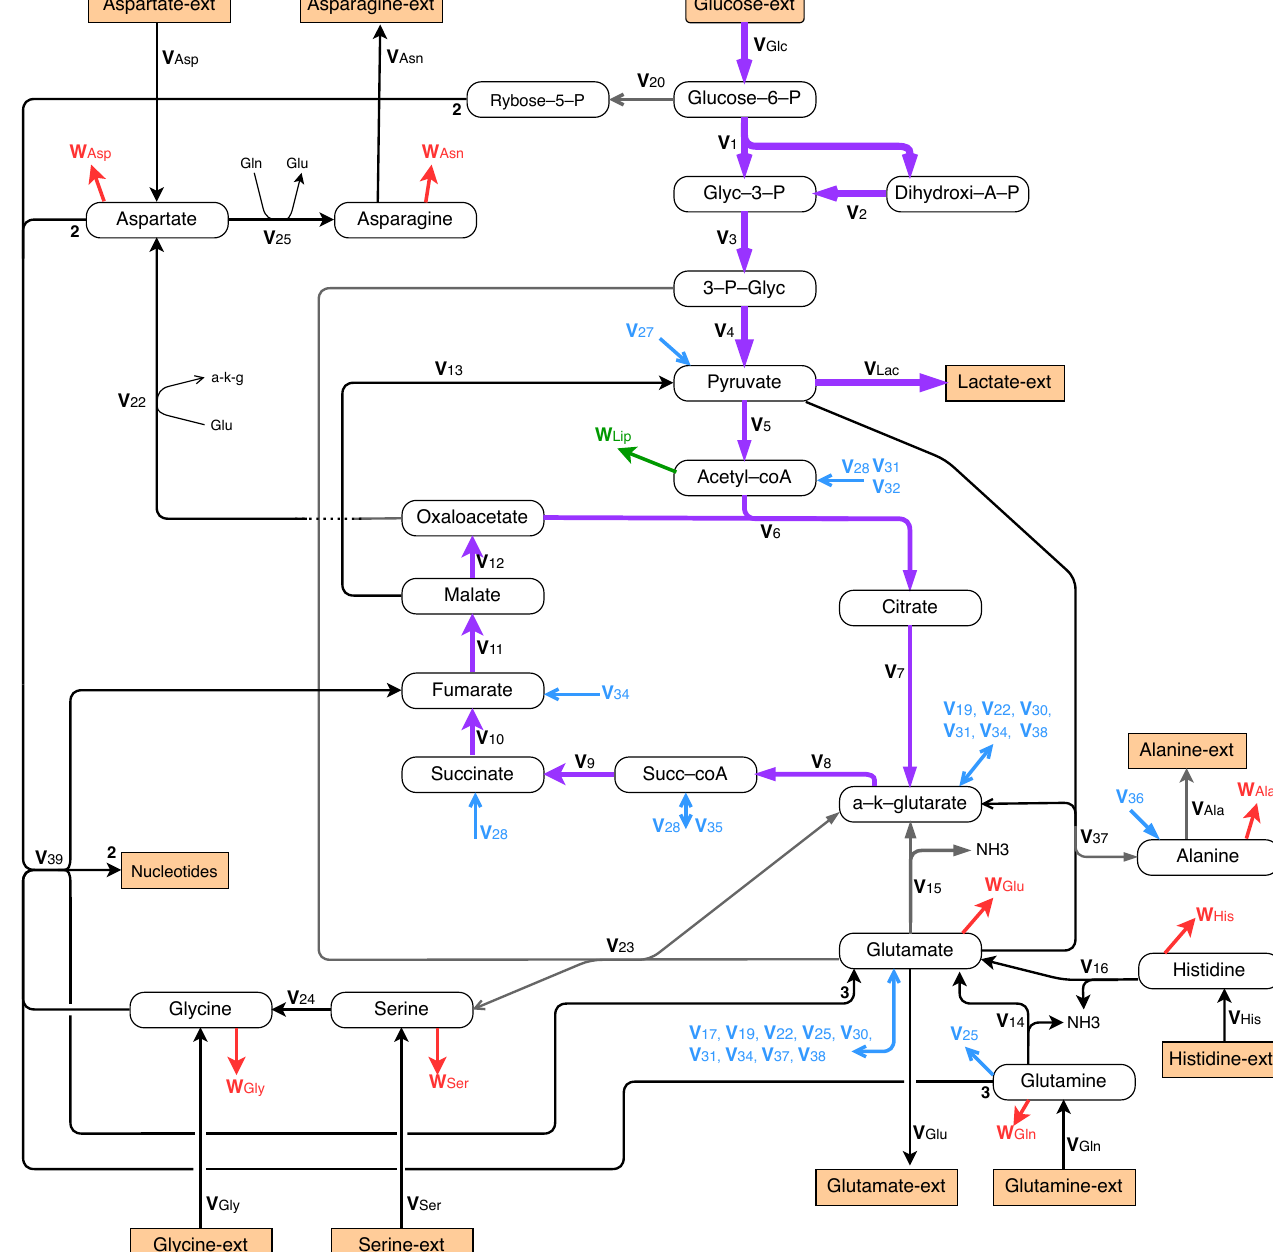
Figure 5. Exponential growth: central metabolism involving glycolysis, TCA, and glutaminolysis, nucleotide synthesis, and metabolism of alanine, asparagine, aspartate, histidine, glycine, and